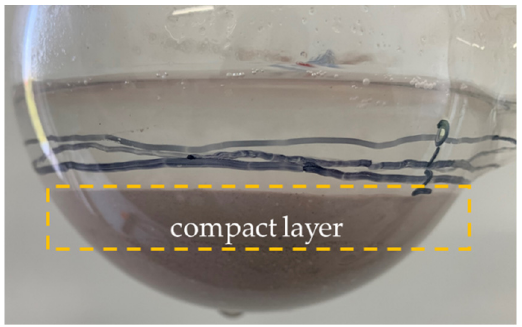
Figure 7. Compact layer formed after injection of PAC30 solution.